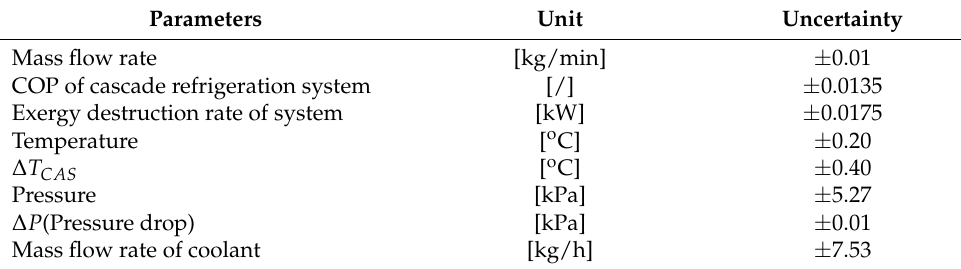
Table 5. Parameters and estimated